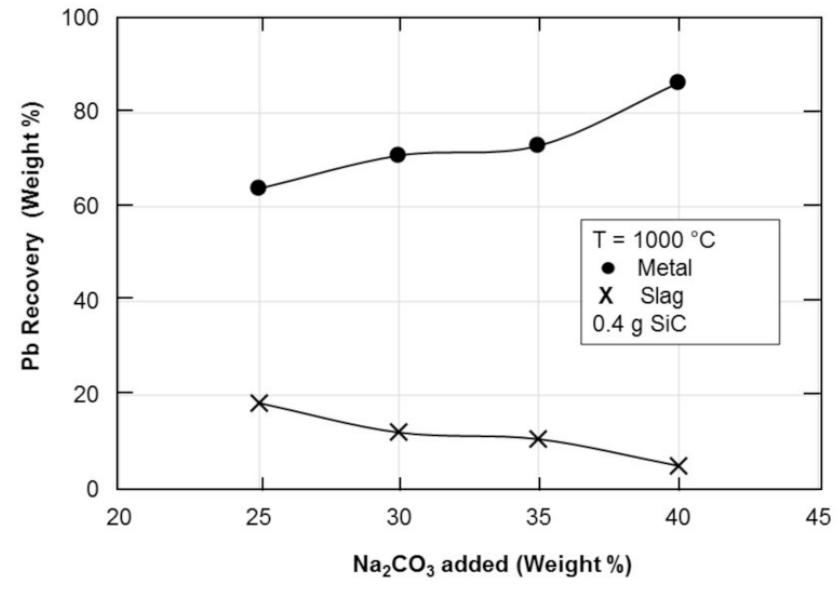
Figure 5. Lead content in metal and slag phases with different amounts of Na 2 CO 3 and 0.4 g SiC to 1000 ◦